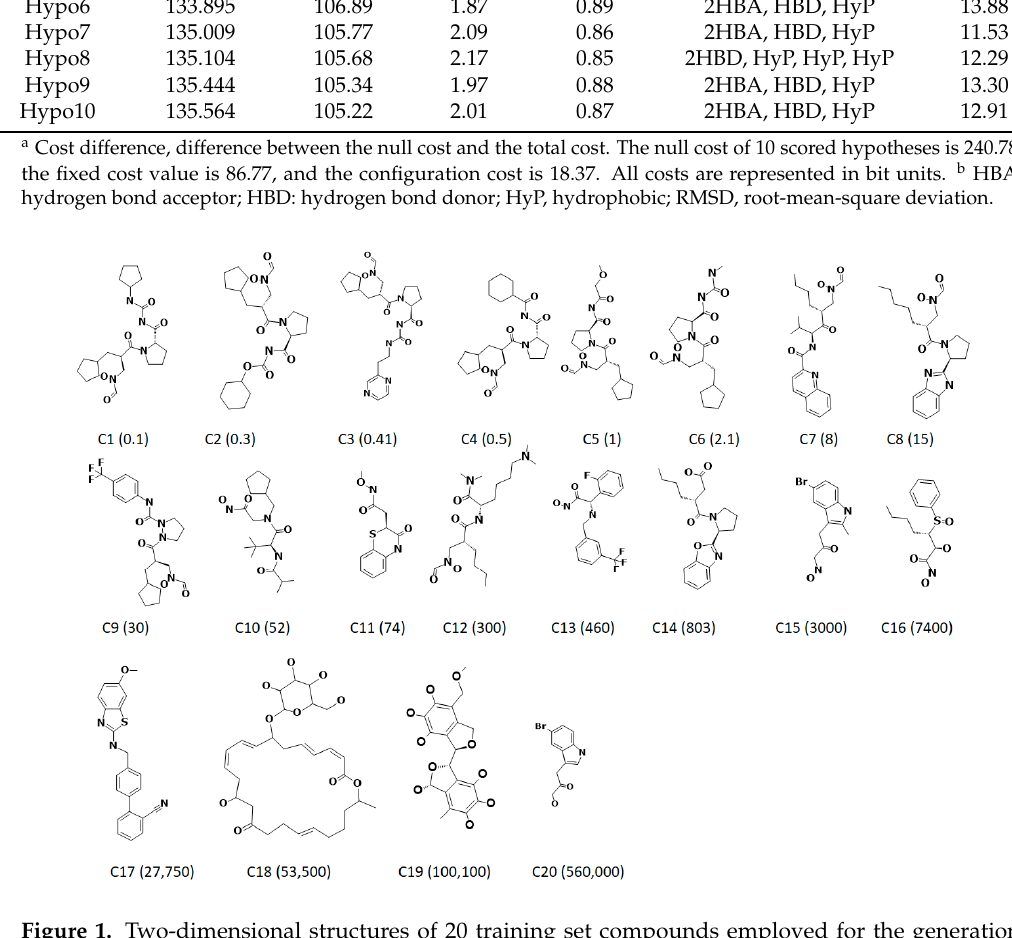
Figure 1. Two-dimensional structures of 20 training set compounds employed for the generation of ligand-based pharmacophore model. The experimentally determined half maximal inhibitory concentration (IC 50 ) values are expressed in nmol/L in parenthesis.